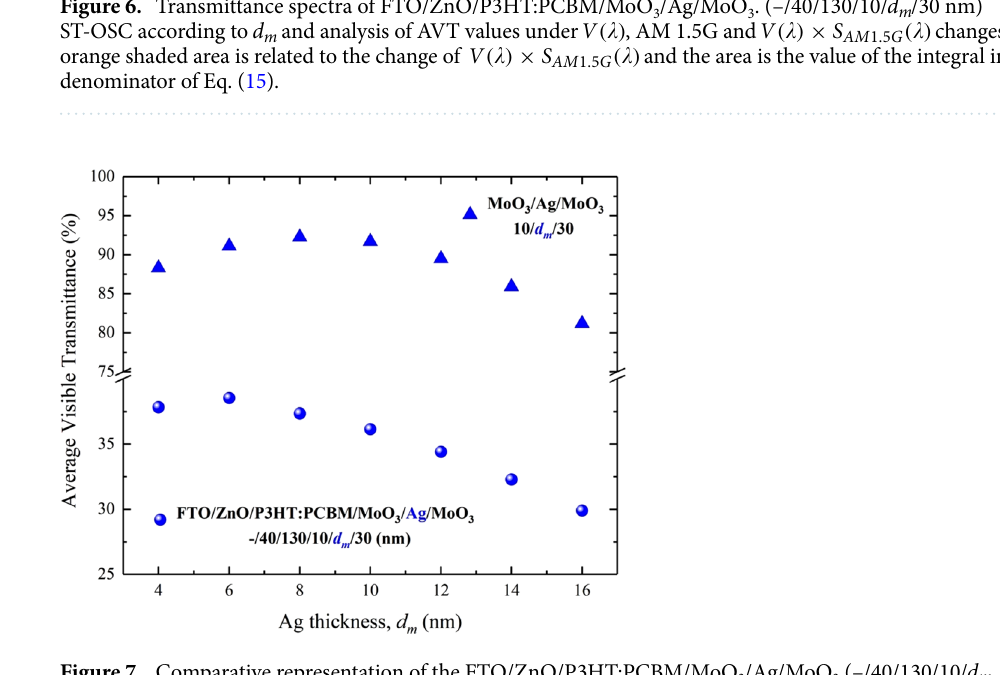
Figure 7. Comparative representation of the FTO/ZnO/P3HT:PCBM/MoO 3 /Ag/MoO 3 (–/40/130/10/ d m /30 nm) ST-OSC and AVT values according to d m of MoO 3 /Ag/MoO 3 (10/ d m /30